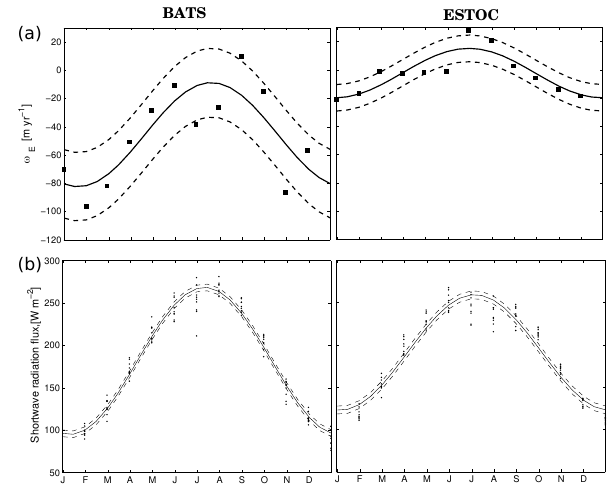
Fig. 3. (a) Vertical Ekman velocity ( w ) at the Ekman depth ( w E ) and (b) surface shortwave solar radiation computed for the period 1996–2001 near BATS and ESTOC. The continuous lines repre- sent the fit to a single harmonic function, whereas the dotted line correspond to the 95% confidence intervals. Fitting of w E to the harmonic function was not used in the